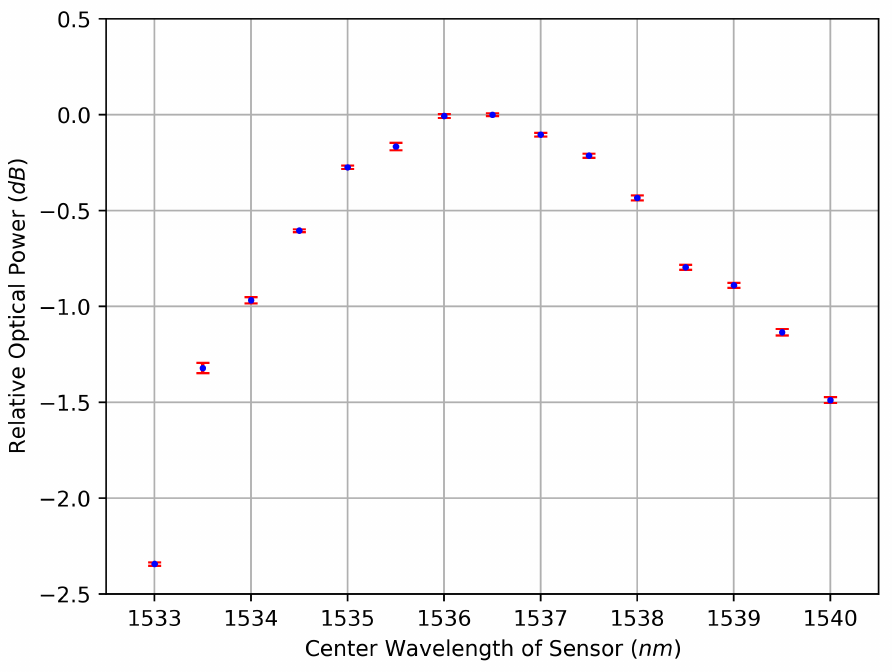
Figure 2. Measured dependency of the optical power from the center wavelength of the sensor. Mean (blue) and standard deviation (red) of 50 readings per sensor position.